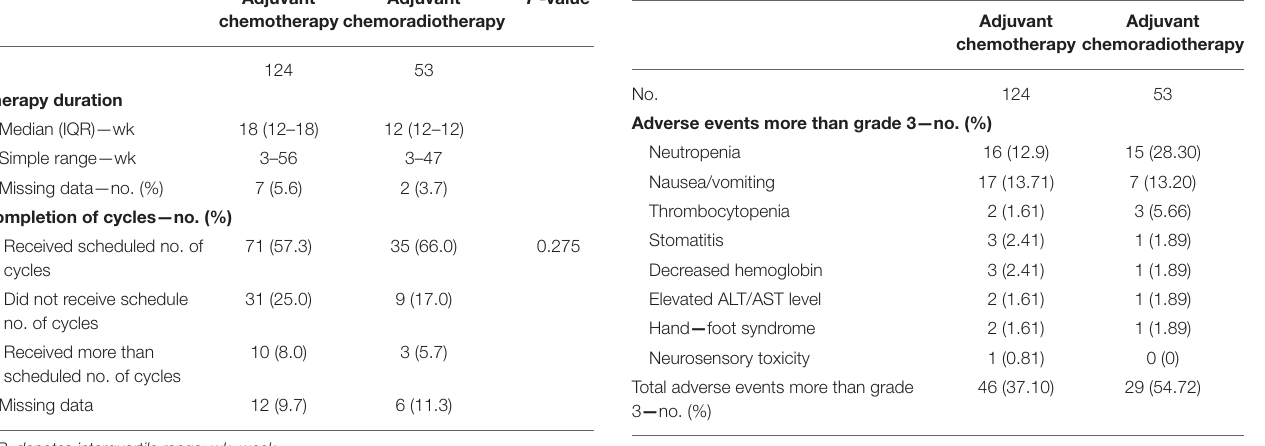
Adjuvant chemotherapy